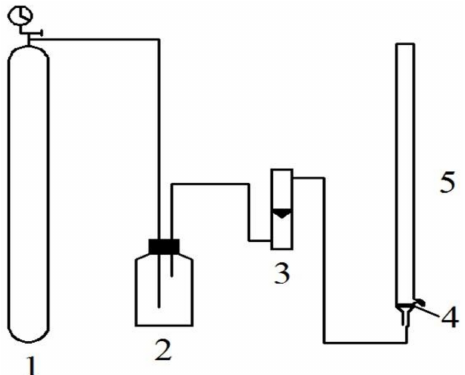
Figure 1. Flotation unit consisted of 1. High-purity nitrogen cylinder; 2. gas buffer device reformed by buoy-type oxygen inhaler; 3. flowrator; 4. G4 glass core; 5. flotation